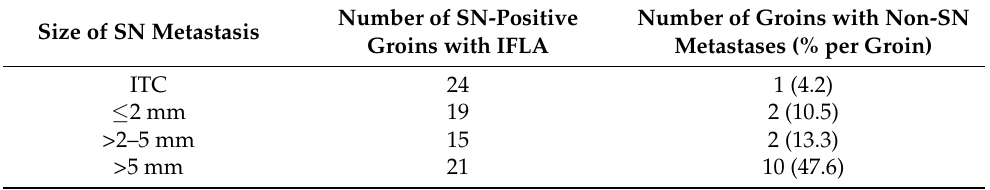
Table 2. The proportion of patients with non-sentinel lymph node metastases according to size of sentinel lymph node